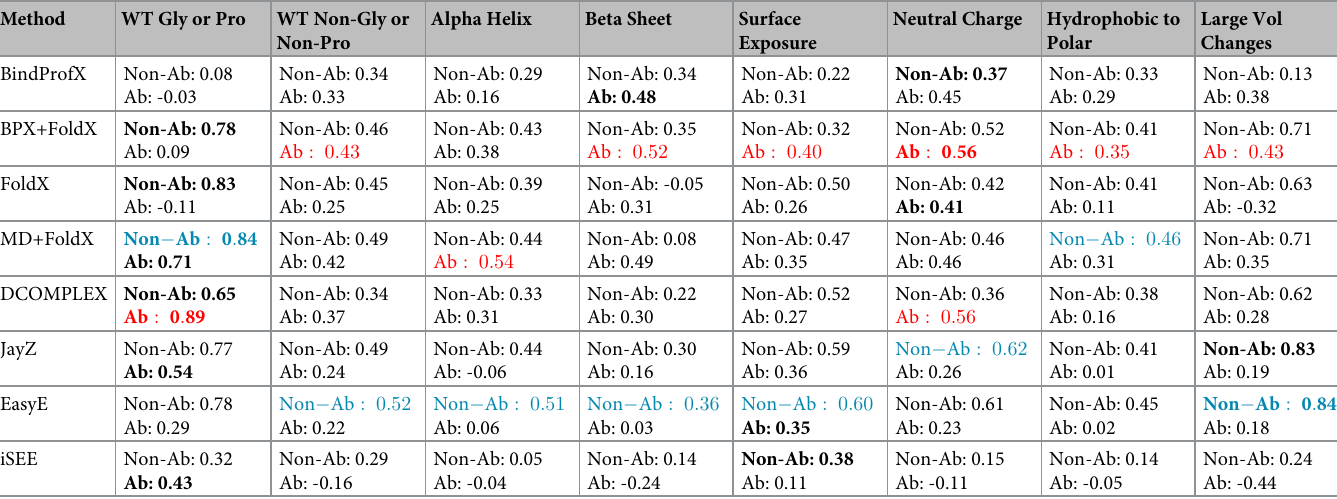
Table 4. All methods r with respect to certain subsets. Method WT Non-Gly or Non-Pro